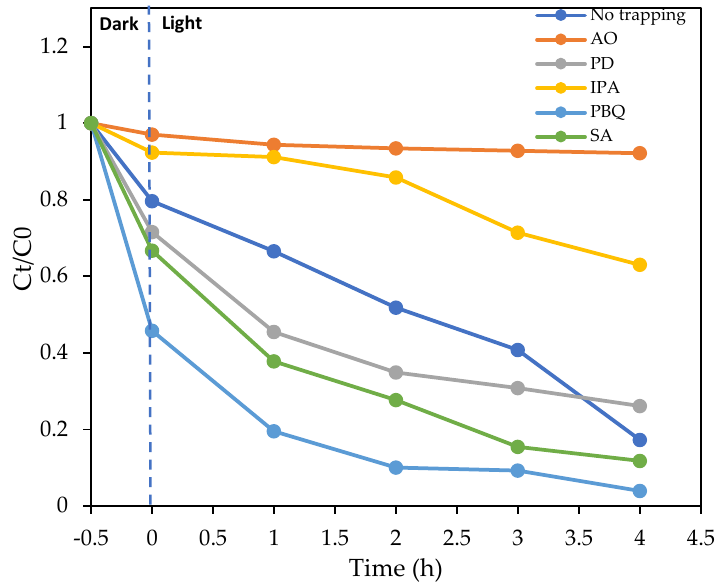
Figure 14. Photocatalytic degradation of DR16 by B-ZnO/TiO 2 under visible light irradiation, in the presence of scavengers used in this study.